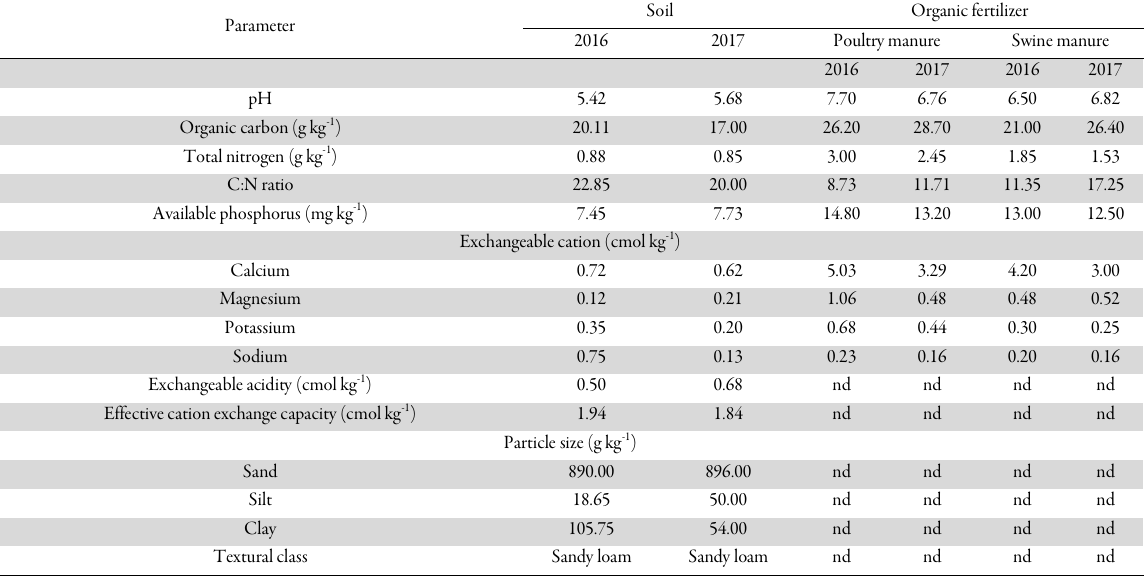
Table 1. Physical and chemical properties of the soil of the experimental site prior to cropping with white Guinea yam and chemical composition of organic fertilizers Parameter